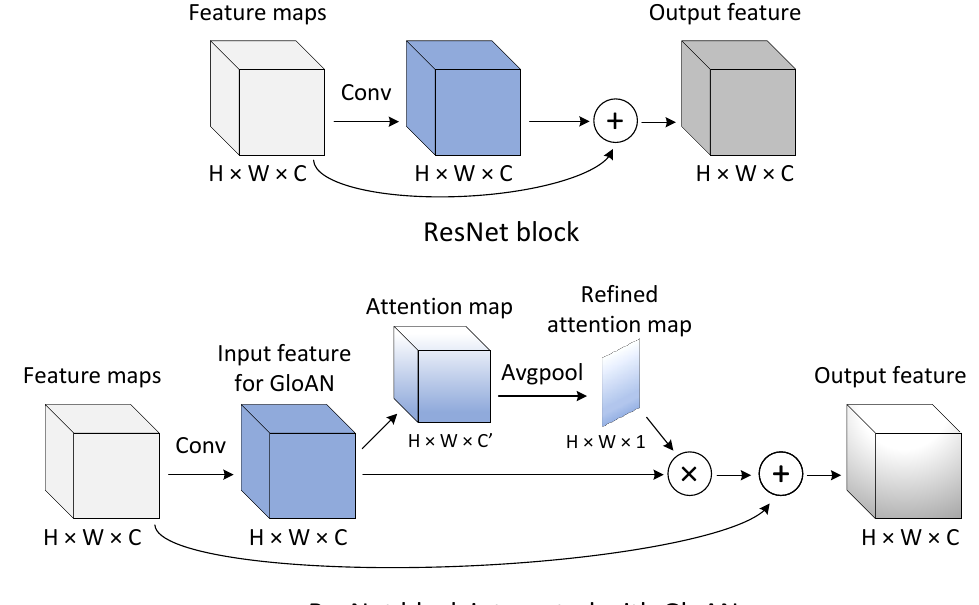
Figure 3. The schema of GloAN integrated into a ResNet